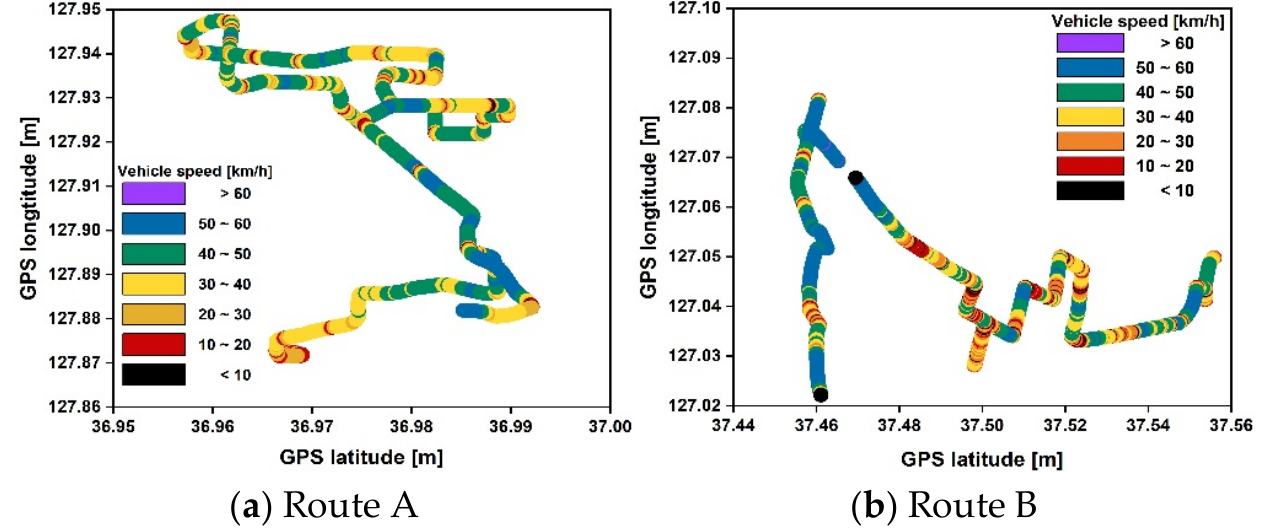
Figure 4. GPS location of urban in RDE routes; the color indicates the vehicle speed.